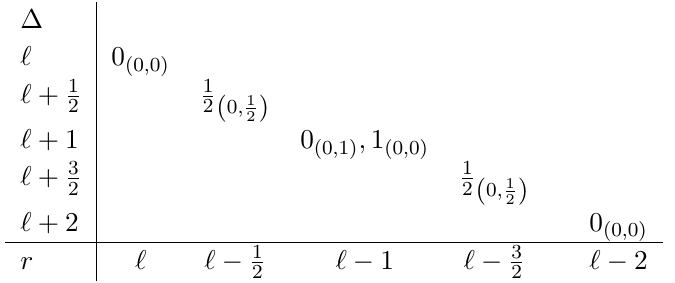
Table 1 . The quantum numbers for states in the E r multiplet.